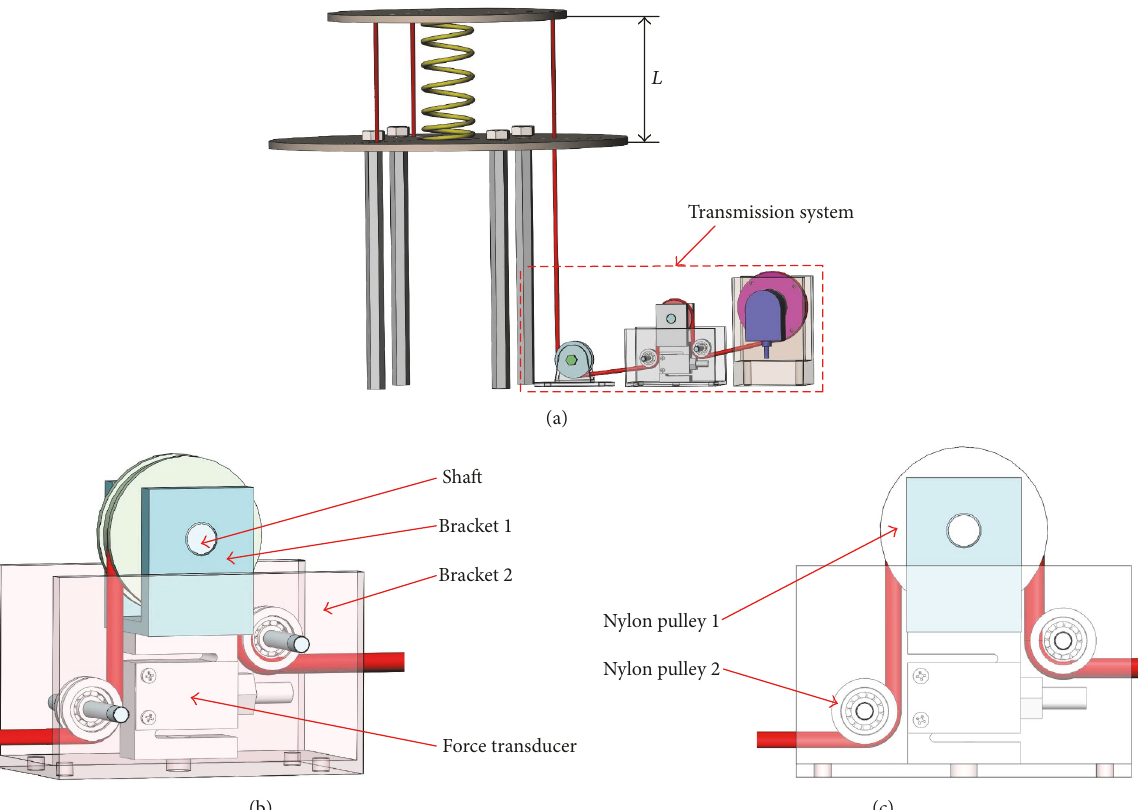
Figure 4: Local mechanical design of the parallel robot: (a) cable force transmission mechanism, (b) perspective 1 of the cable force measuring mechanism, and (c) perspective 2 of the cable force measuring